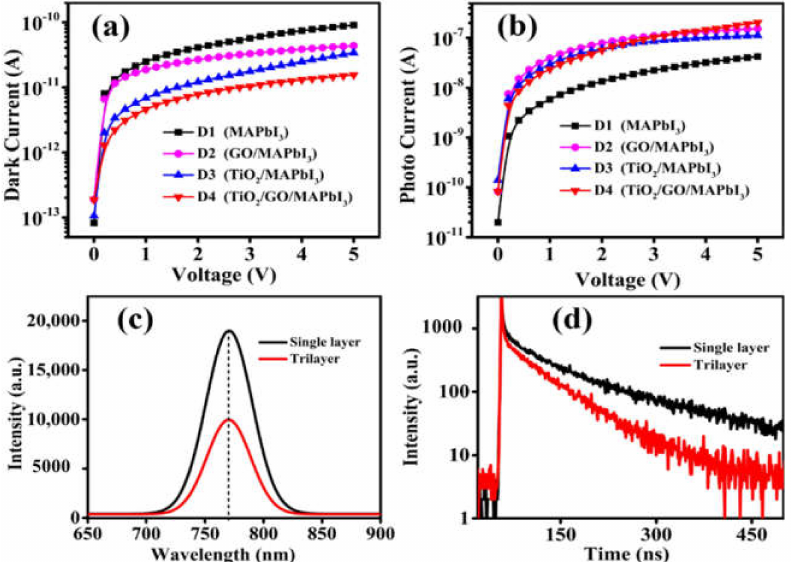
Figure 4. I – V curves of D1 (MAPbI 3 ), D2 (GO/MAPbI 3 ), D3 (TiO 2 /MAPbI 3 ), and D4 (TiO 2 /GO/MAPbI 3 ) trilayer devices ( a ) under dark and ( b ) under white light illumination of 0.1 mWcm − 2 . ( c ) Photoluminescence (PL) spectra, ( d ) time-resolved PL of single layer (without GO) and trilayer (with GO)